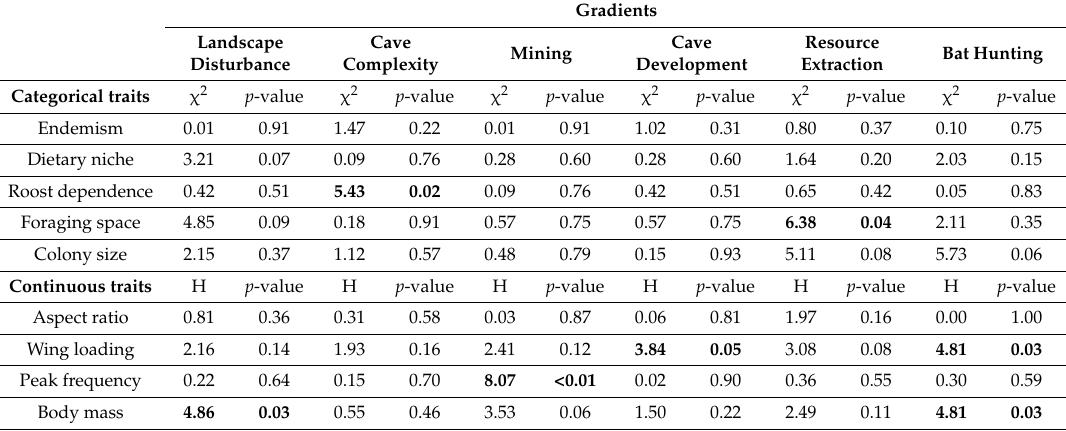
Table 3. Comparison of ecological traits between ‘winner’ and ‘loser’ bat species across environmental and human disturbance gradients. Gradients Landscape Cave Cave Resource Mining Bat Disturbance Complexity Development Extraction